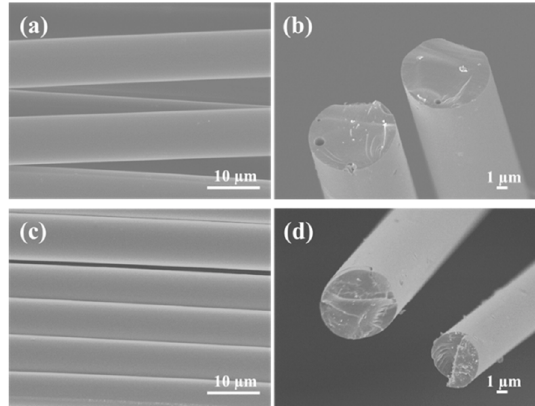
Figure 9. SEM of CFs obtained from ( a , b ) HPC-MNS-SP240; ( c , d ) HPC-QS-SP260 derived pitches (( a , c ) are surface section of fibers, ( b , d ) are cross-section of fibers).